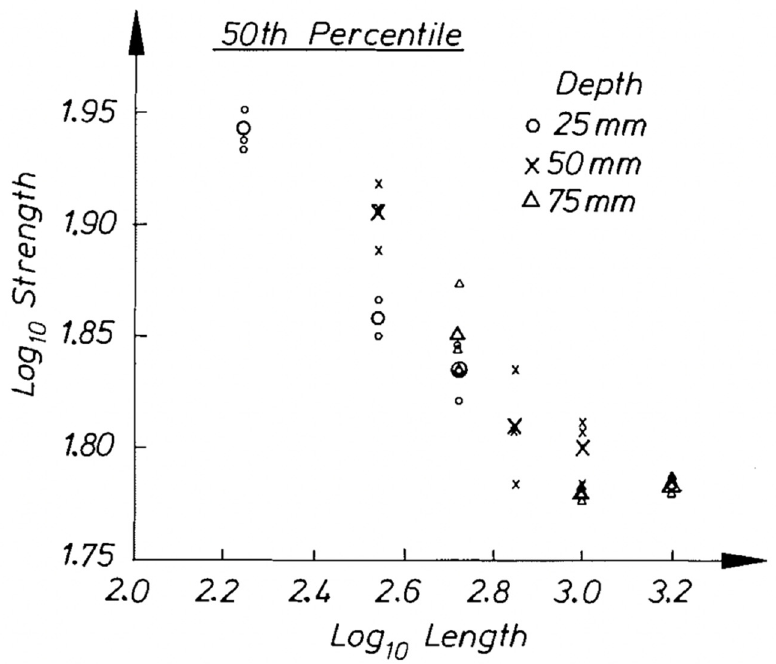
Figure 36. Plot of log(strength) versus log(length) for Canadian Spruce ( Picea glauca ). From [104]. Madsen and Buchanan also took a new approach to the study of size effects by con- sidering bending [86]. Bending is the mode of loading that most wood used in construc- tion is subjected to (up to that point, only shear and tension had been included in Cana- dian design standards). Figure 37 shows the differences between the tensile, compressive and bending strengths. The bending strength can be seen to be intermediate between ten- sile and compressive strength, which makes sense since bending is a mixture of tension and compression. Figure 38 shows that wood is brittle in tension and ductile in compres- sion (see also Figures 10 and 11). Failure in bending can be either brittle (Figure 39) or ductile (Figure 40).